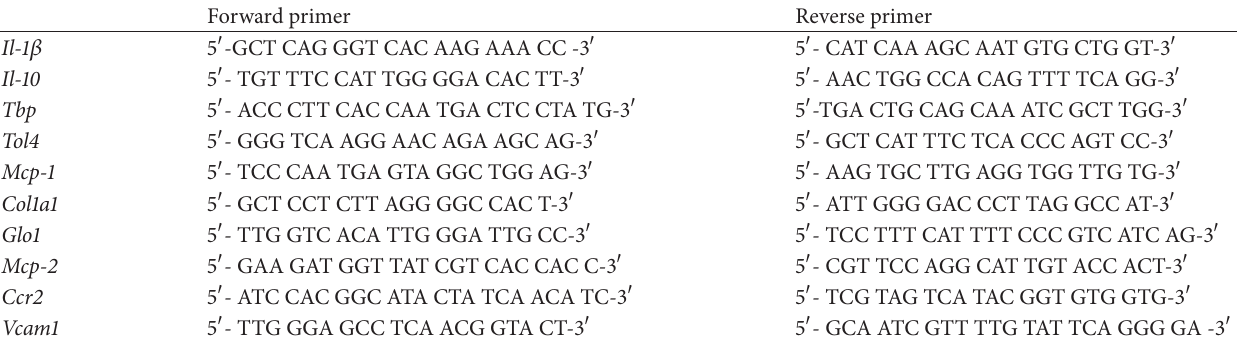
Table 1: DNA primer pairs used in this